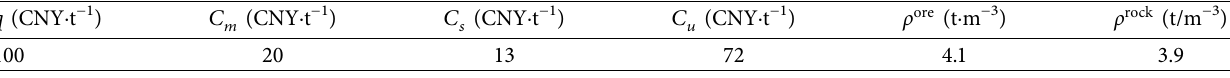
Table 2: Inputs for optimizing the surface-to-underground mining transition in the Dagushan iron mine. q (CNY · t − 1 )